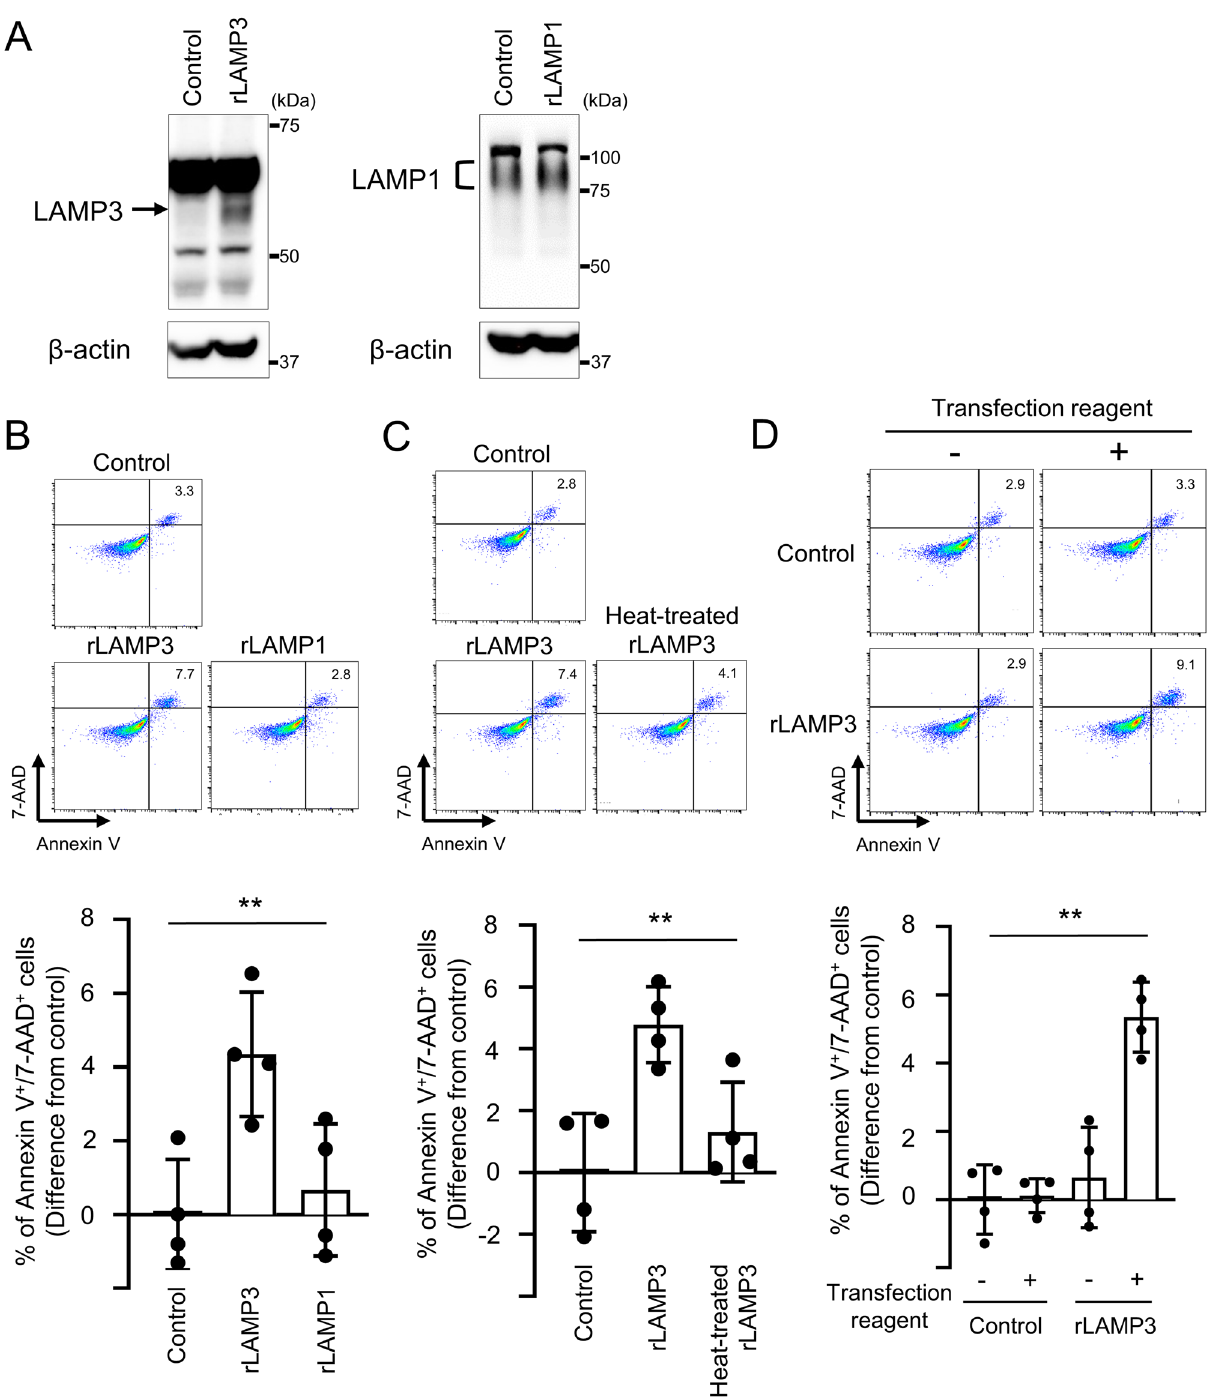
Figure 6. Transfection of recombinant LAMP3 protein induces apoptosis in A253 cells. ( A ) Representative Western blots of A253 cells transfected with recombinant LAMP3 (rLAMP3), recombinant LAMP1 (rLAMP1), or control FLAG peptide (uncropped images are provided in Supplementary Fig. 3). ( B ) Apoptotic cells were determined in A253 cell culture by flow cytometry using APC Annexin V/7-AAD 14 h after transfection. Graph showing difference in mean (± SD) number of Annexin V + /7-AAD + cells in A253 cell culture transfected with rLAMP3 or rLAMP1 compared with control. ( C ) A253 cells were transfected with rLAMP3, heat-treated rLAMP3, or FLAG peptide. Apoptotic cells were determined in A253 cell culture by flow cytometry using APC Annexin V/7-AAD 14 h after transfection. Graph showing difference in mean (± SD) number of Annexin V + /7-AAD + cells in A253 cell culture transfected with rLAMP3 or heat-treated rLAMP3 compared with control. ( D ) A253 cells were treated with control FLAG peptide or rLAMP3 alone (without transfection reagent) or transfected with control FLAG peptide or rLAMP3 with transection reagent. After 14 h, number of apoptotic cells was determined by flow cytometry using APC Annexin V/7-AAD. Graph showing difference in mean (± SD) number of Annexin V + /7-AAD + cells in cell culture treated with rLAMP3 alone or transfected with FLAG peptide or rLAMP3 compared with FLAG peptide alone. ** p < 0.01 (one-way ANOVA, n = 4 for all the